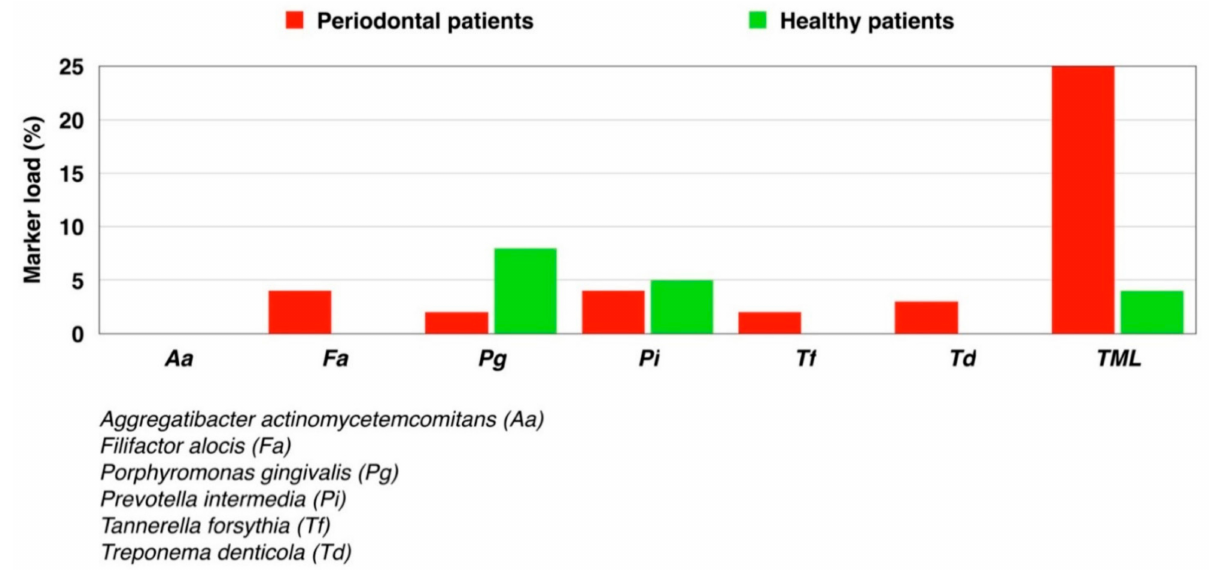
Figure 3. Marker load (%) of known pathogenic markers for periodontal bacterial species tested in healthy and periodontal patients. TML: Total marker